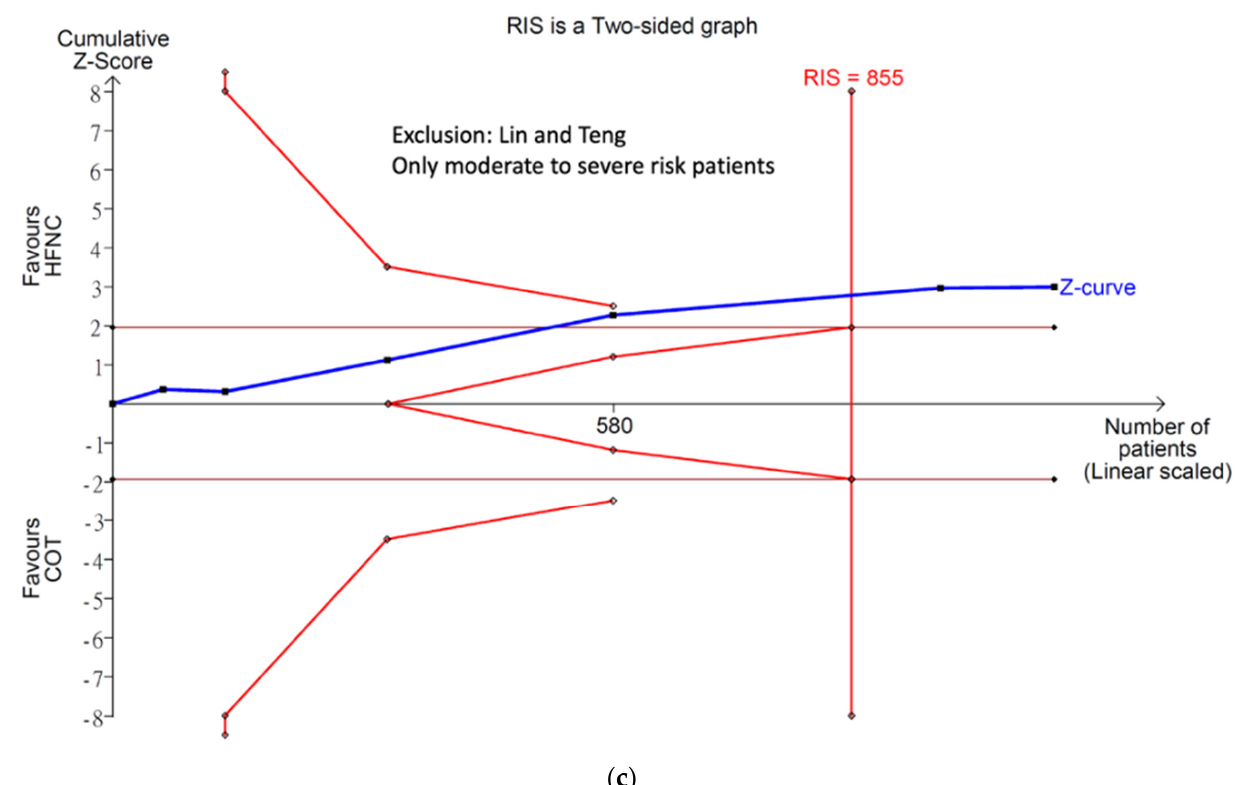
Figure 3. Incidence of hypoxemia. ( a ) Meta-analysis with IVhet model; ( b ) trial sequential analysis; and ( c ) trial sequential analysis: Patients with moderate to high risk for hypoxemia. Studies in Figure 3a include Riccio et al [3], Nay et al [16], Thiruyenkatarajan et al [15], Kim et al [17], Lee et al [18], Mazzeffi et al [14].